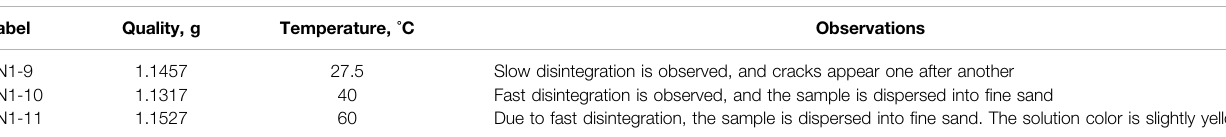
TABLE 4 | The sample information for temperature effects